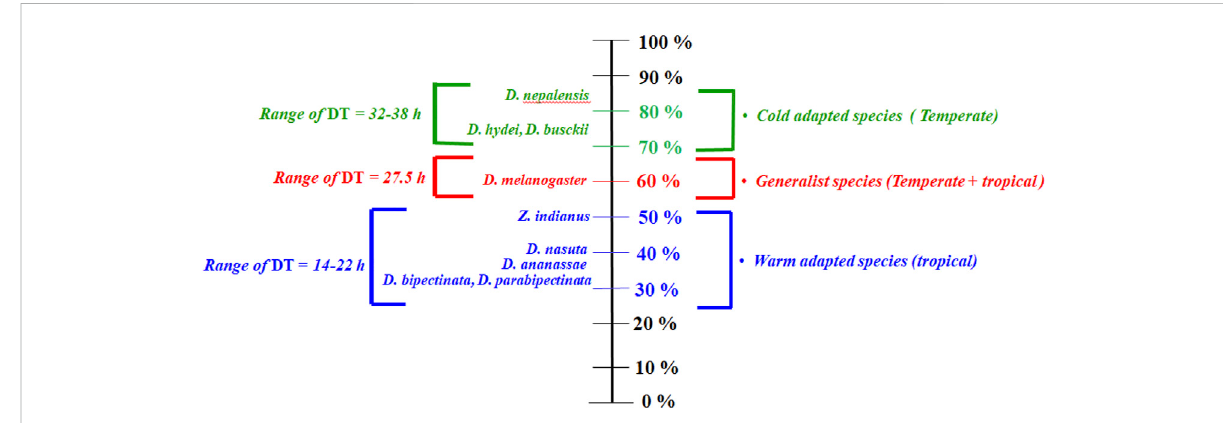
FIGURE 1 Scale for categorizing Drosophila species according to their dehydration tolerance. The 0% shows a lack of desiccation tolerance, while the 100% shows great desiccation tolerance. Range of DT is resistance to desiccation (in hours) of these species.